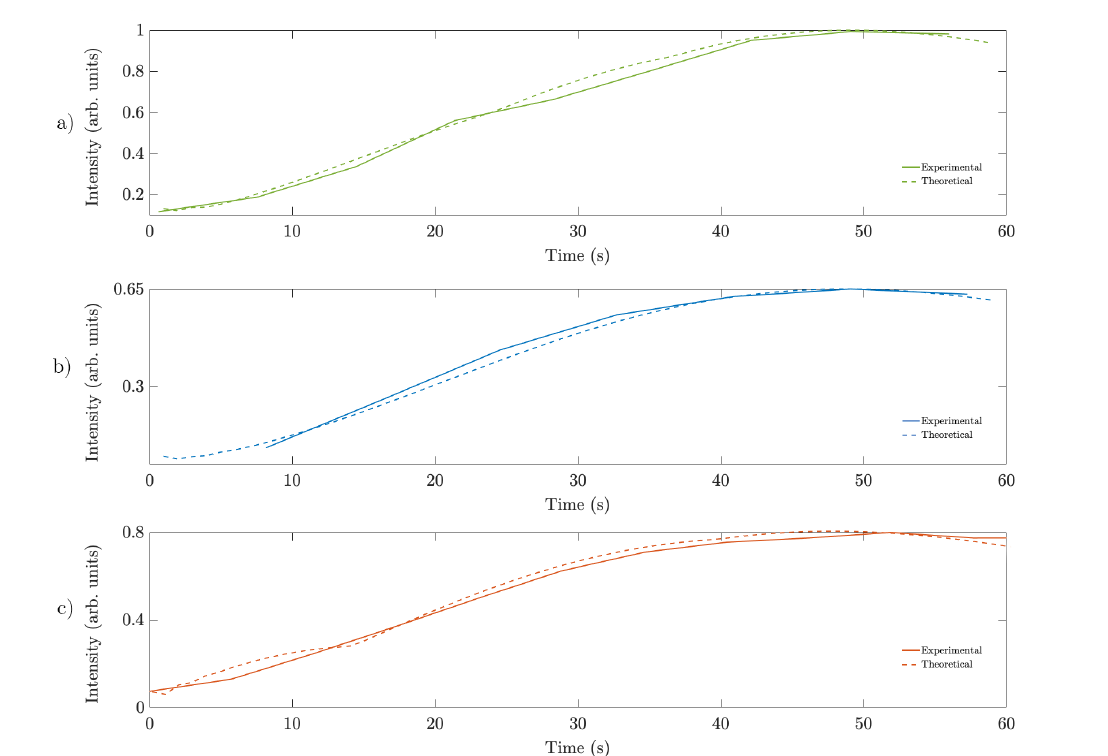
Figure 11. Simulated normalized intensity as a function of recording time at the focal point for different multiplexing schemes. ( a ) 30 sectors; ( b ) random multiplexing 8 × 8 and ( c ) random multiplexing 1 × 1.